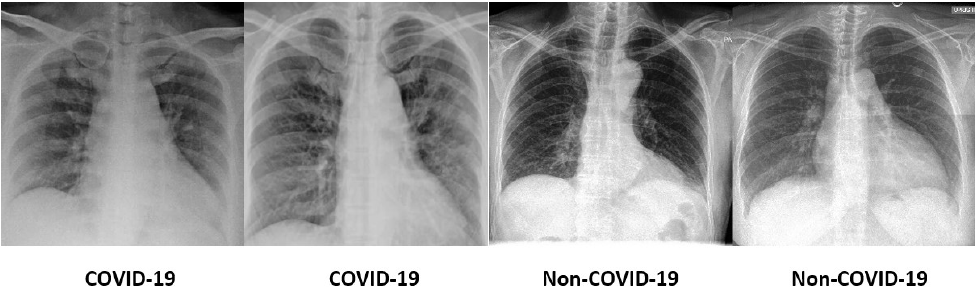
Figure 1. Some sample COVID-19 and non-COVID-19 images from the COVID-Xray-5k